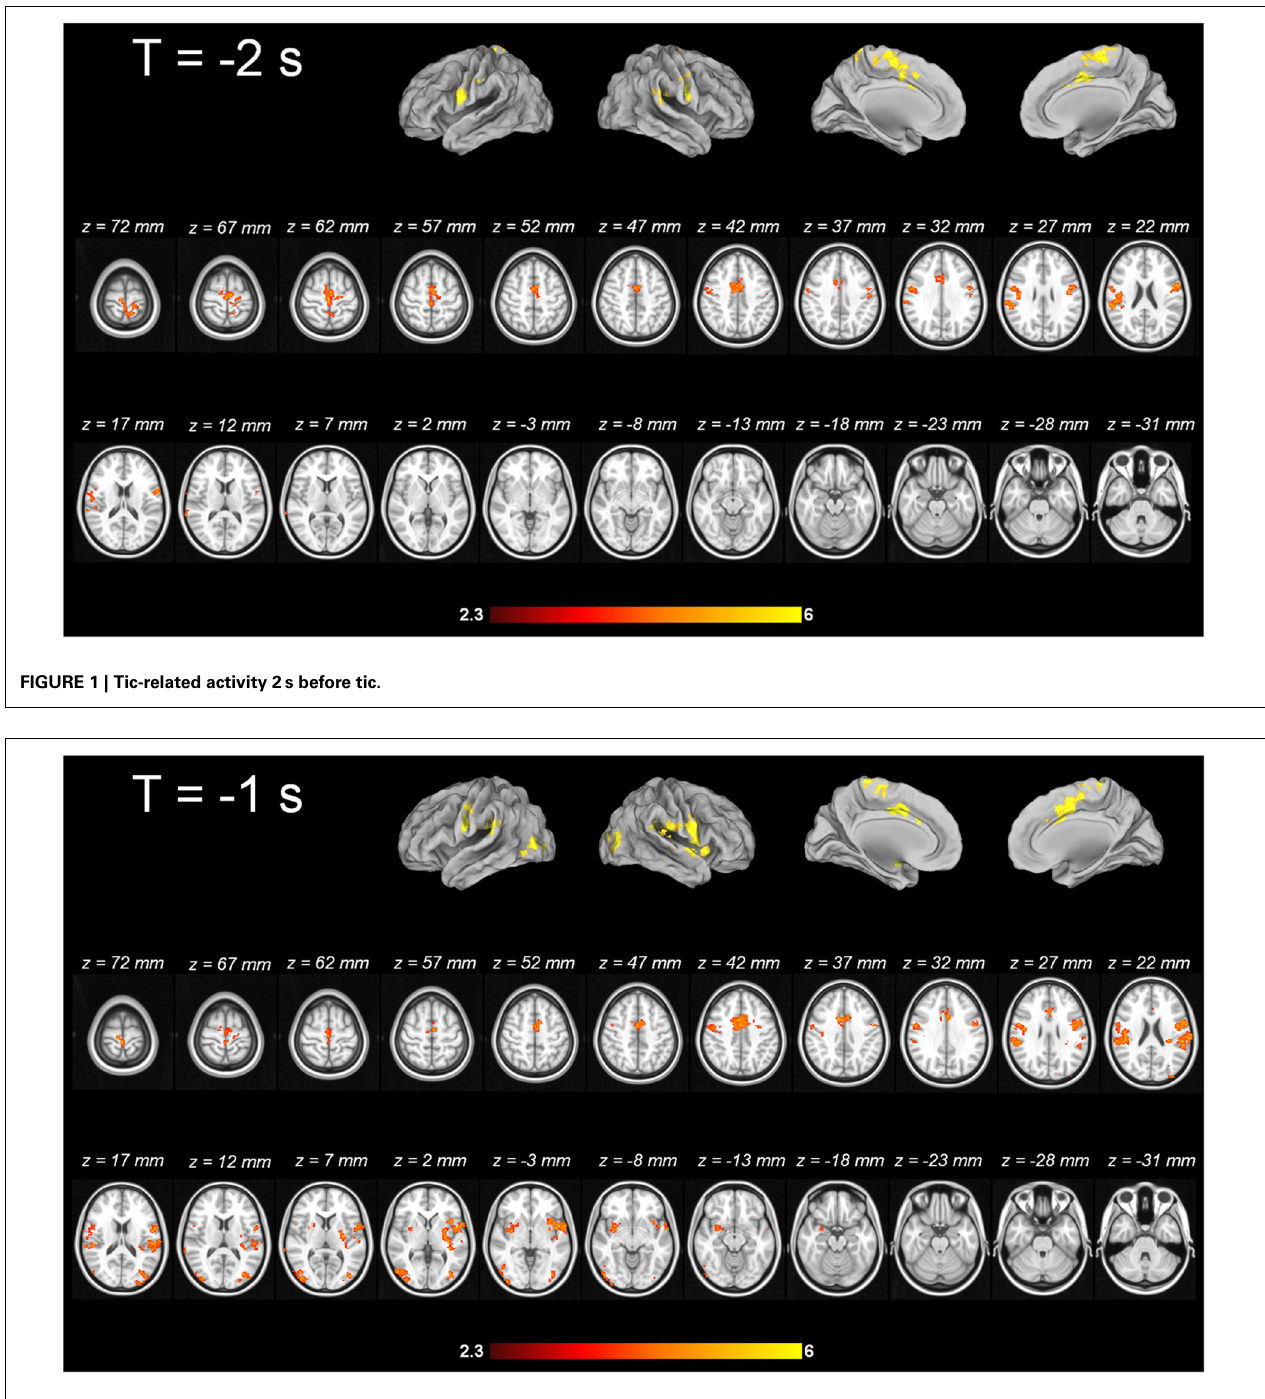
FIGURE 2 | Tic-related activity 1s before tic.